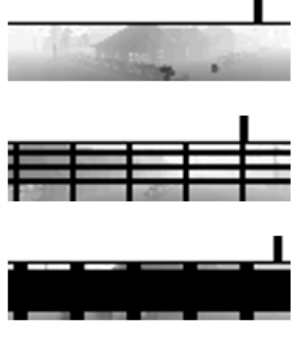
Figure 6. The State Image and Encoded Section.